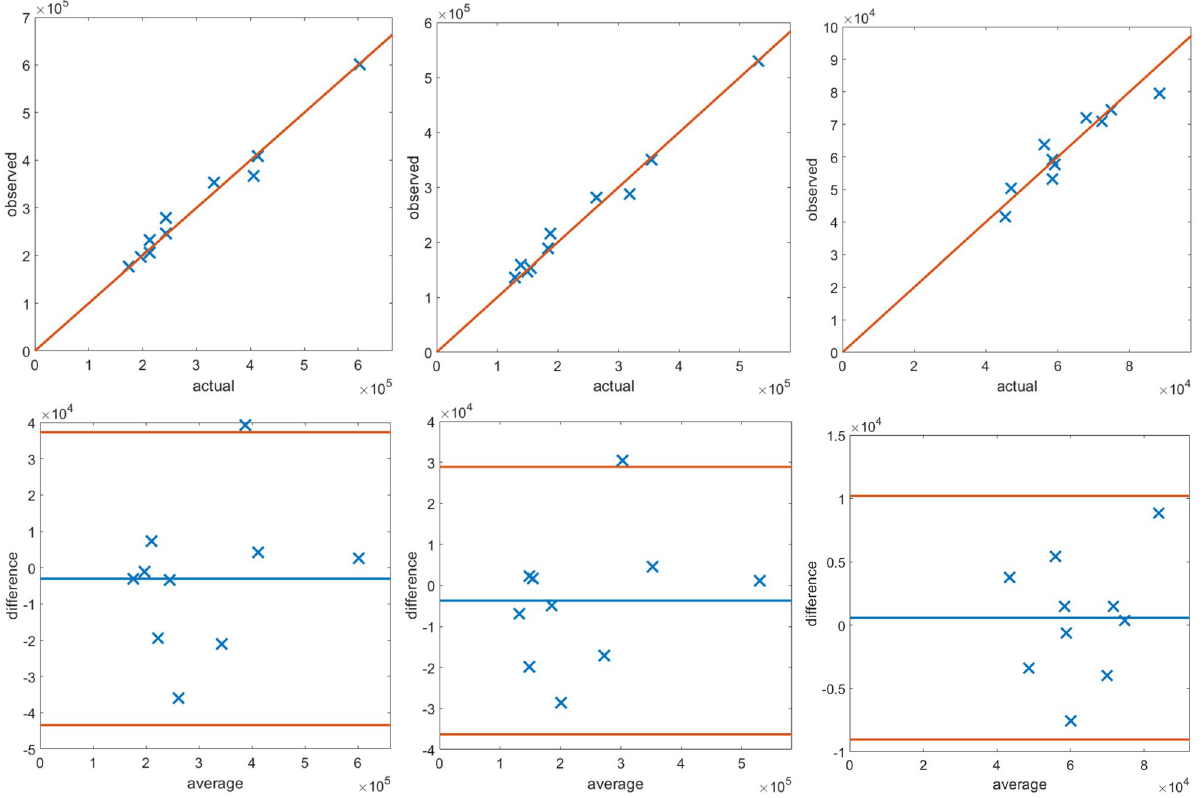
Figure 2. Correlation (top row) and agreement (bottom row) between the proposed hybrid approach and the ground truth in voxel detection for the aortic data. Units are the number of